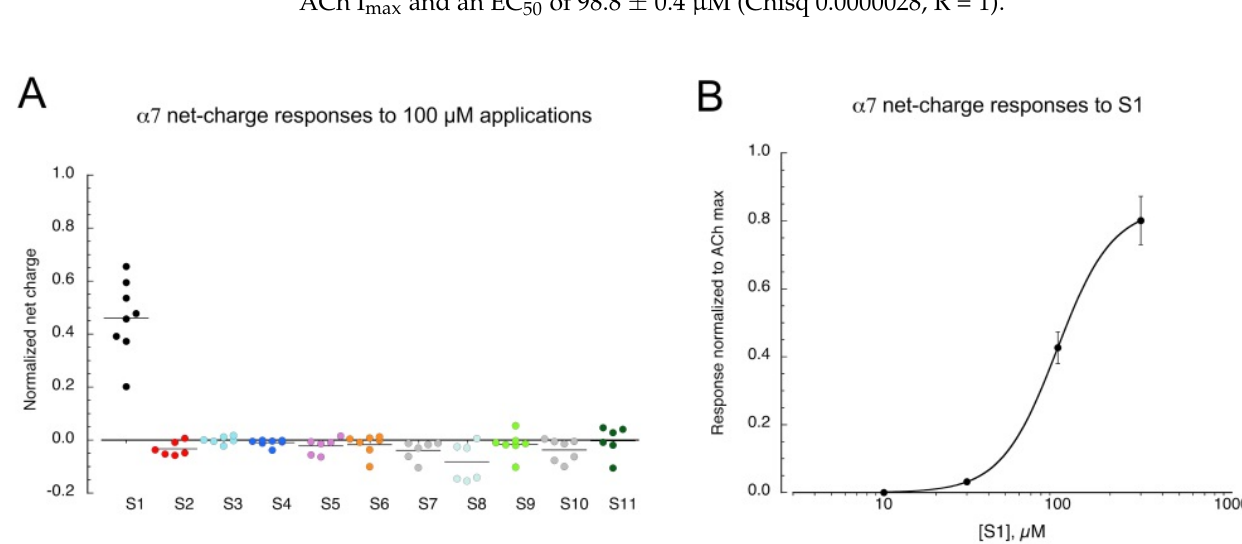
Figure 3. Responses of α 7 nAChR to sulfonium compounds coapplied with PAMs. ( A ) Potentia- tion of α 7 responses with 30 µM racemic TQS. Shown are the average net-charge responses of seven or eight oocytes ± SEM. ( B ) Concentration-response studies of peak currents generated by compounds that gave positive responses with TQS, coapplied with 10 µM PNU-120596. Each point represents the average (±SEM) of at least four oocytes. See Table 1 for curve-fit values.